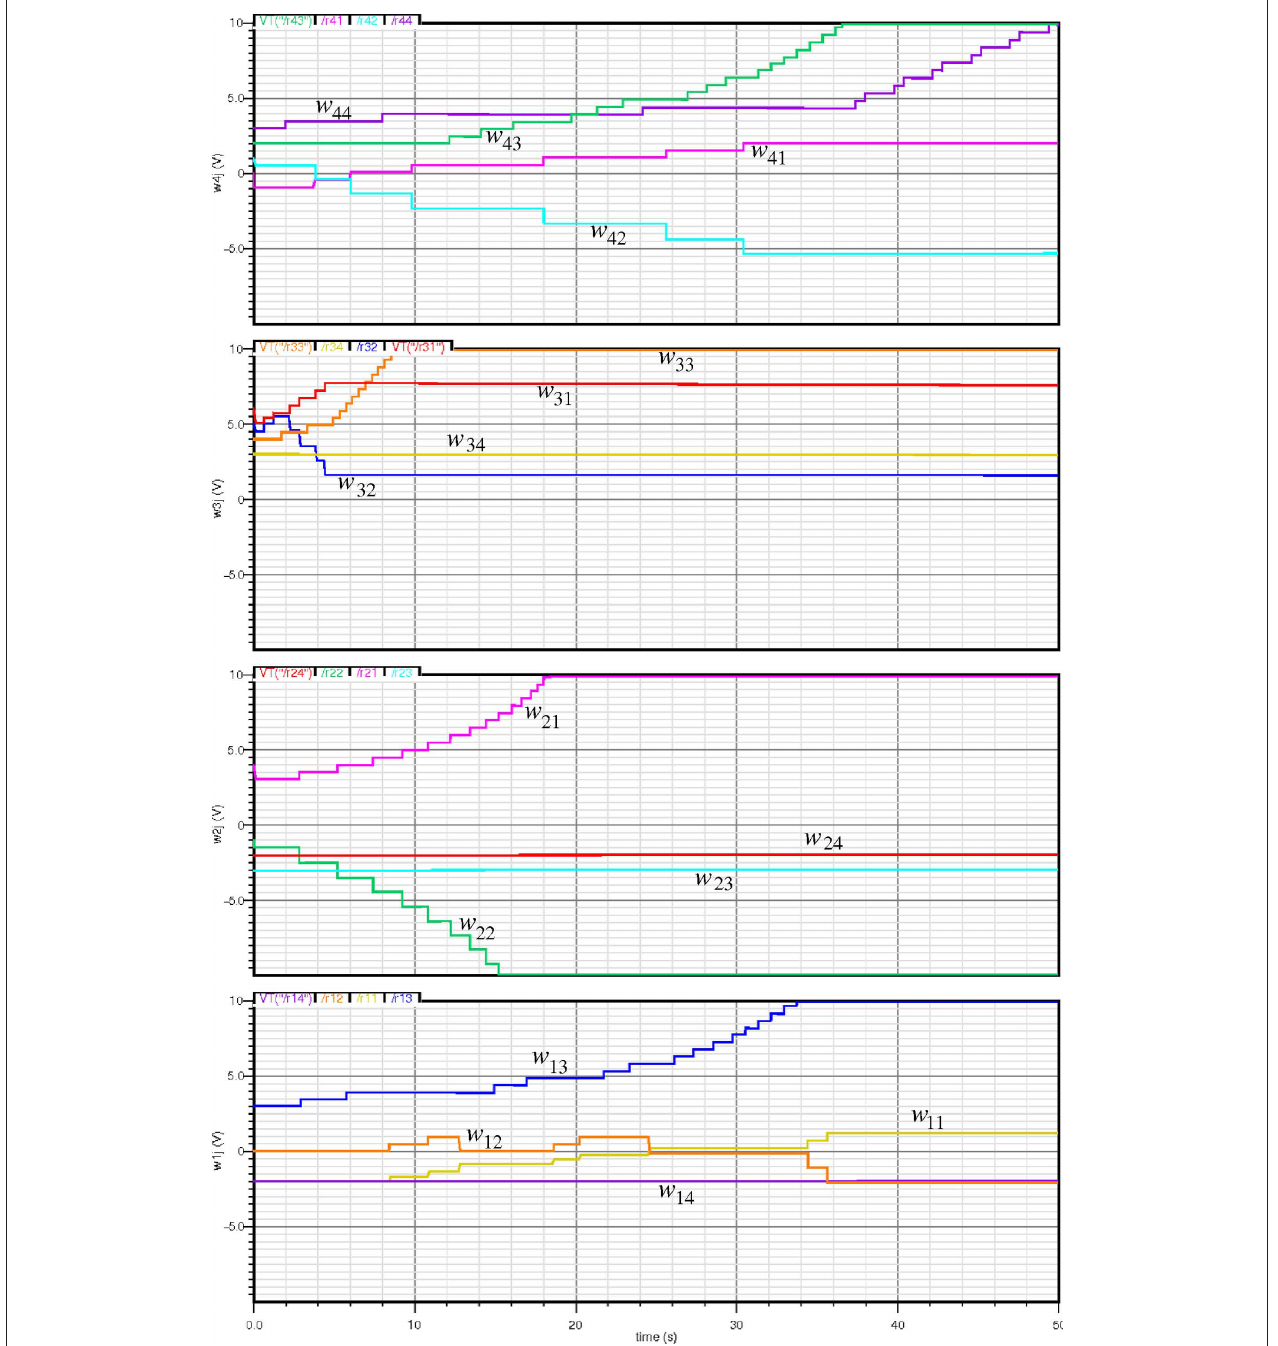
Figure 19 | Simulated evolution of weights ( w in Figure 17A) for the FeT network in Figure